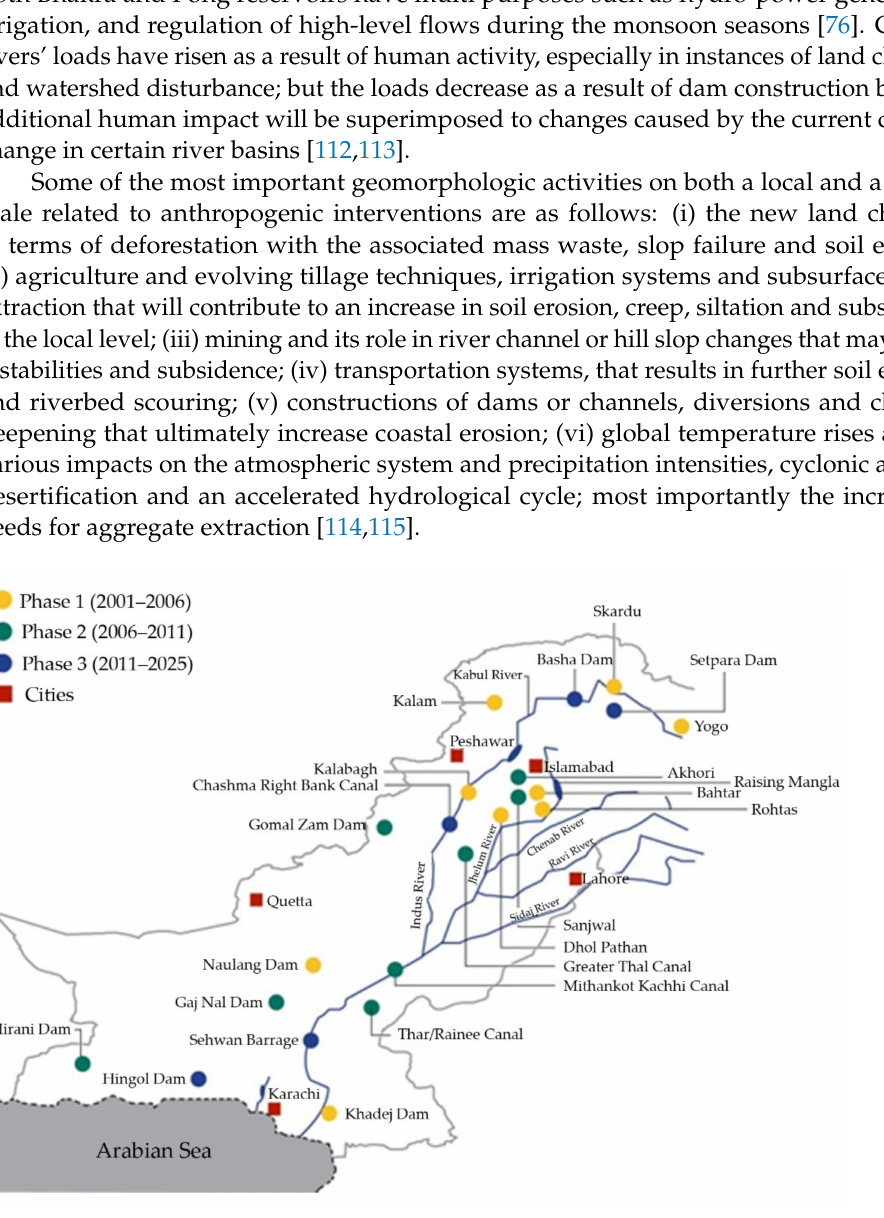
Figure 6. Location of dams constructed on different rivers in